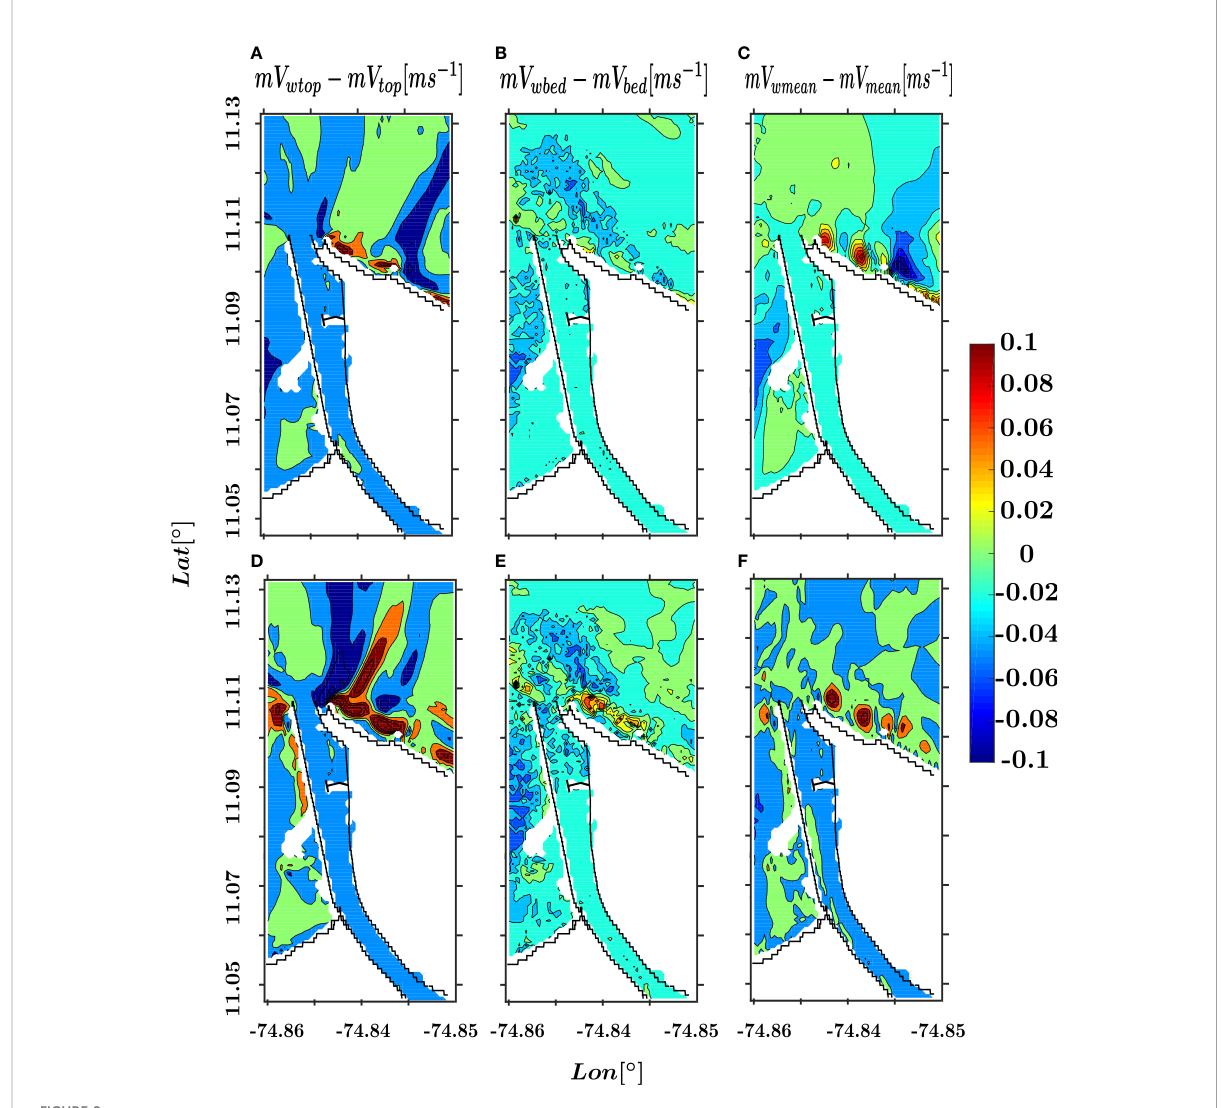
FIGURE 8 Differences in tidally averaged velocity magnitude, with and without waves at the surface (A, D) . Bottom (B, E) , and vertically averaged (C, F) , in 2018 (A – C) , and 2020 (D – F)